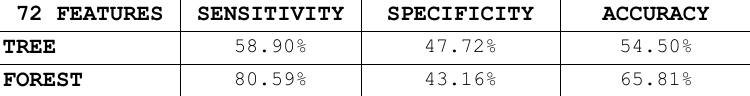
Table 8. Four color slope value metrics.